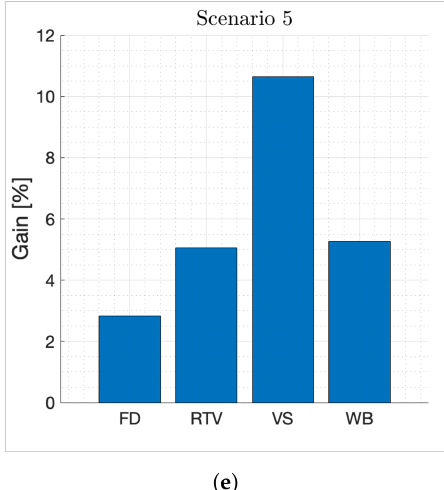
Figure 7. Percentage of gain achieved by the proposed solution for each service in every scenario. ( a ) Gain in Scenario 1. ( b ) Gain in Scenario 2. ( c ) Gain in Scenario 3. ( d ) Gain in Scenario 4. ( e ) Gain in Scenario